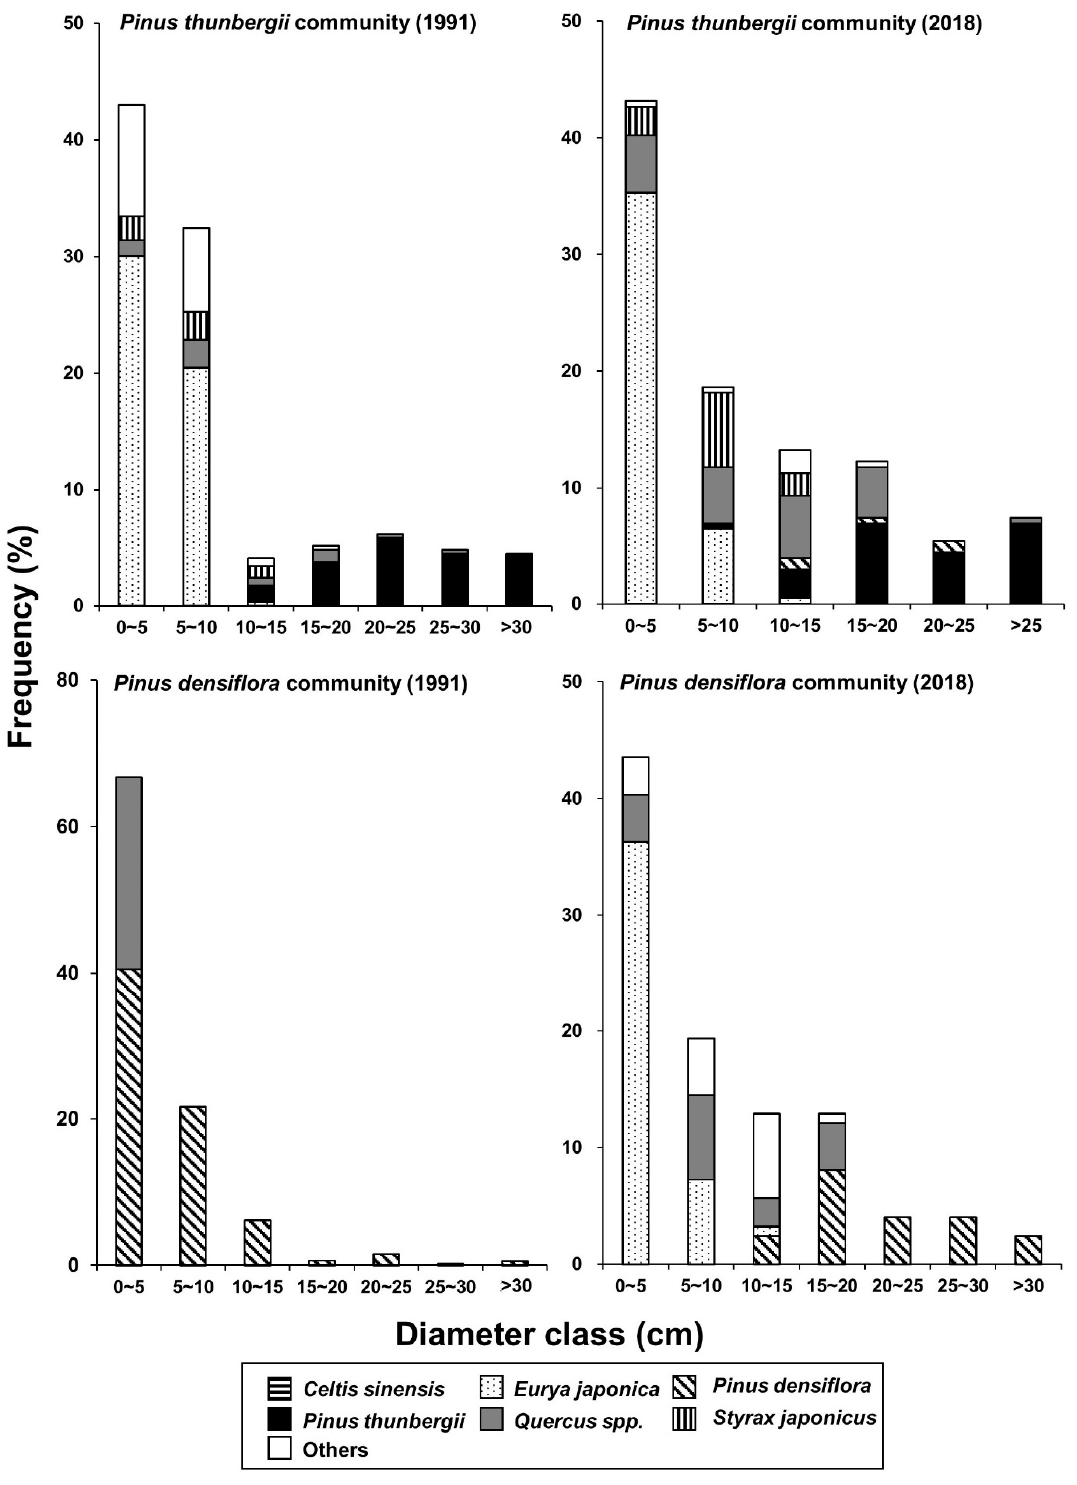
Figure 4. Frequency distribution diagrams of diameter class of tree and two shrub species in three vegetation types: grassland1 ( M.sinensis var. purpurascens community), grassland2 ( P. americana community), shrubland ( S. japonicus community), and forest ( P. densiflora community, P. thunbergii